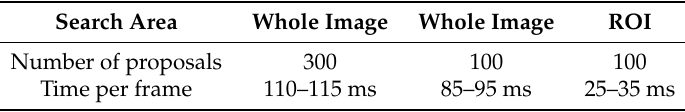
Table 3. Real-time